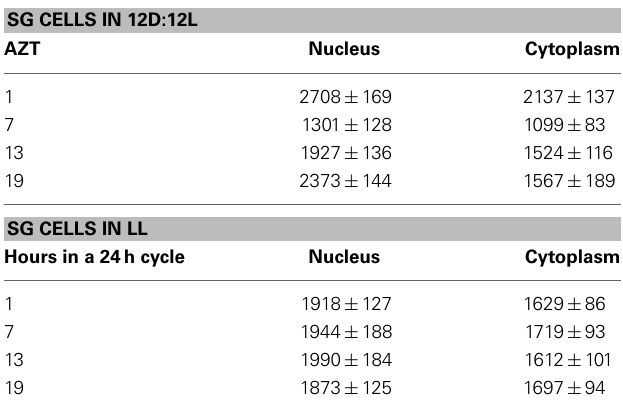
Table 3 | SG cells (mean relative PER fluorescence ± SEM every 6h throughout a